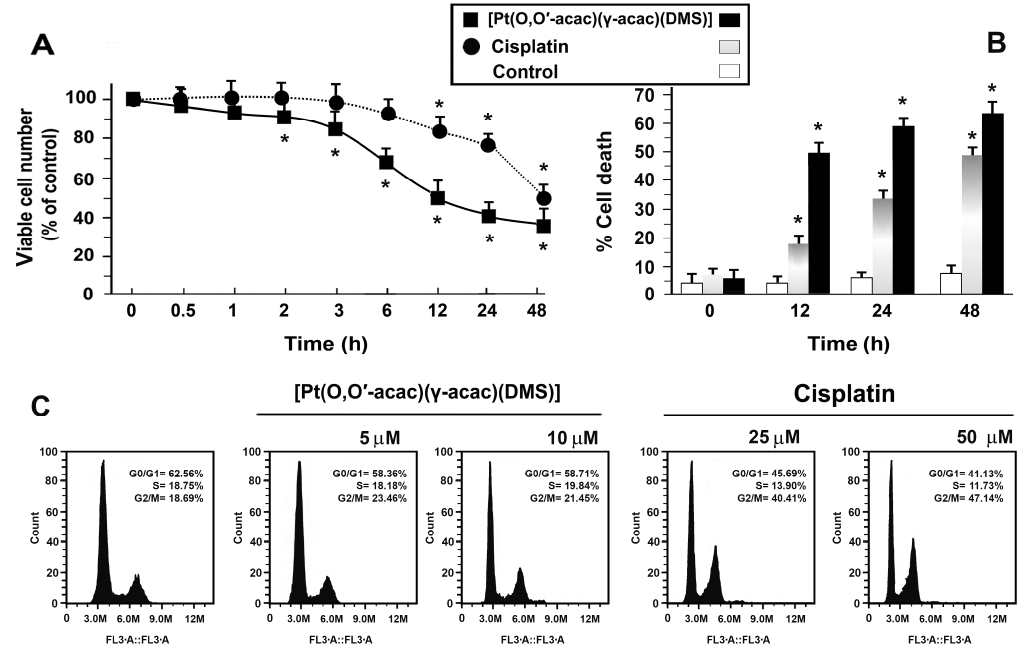
Figure 1. Cytotoxic effects of [Pt( O,O ’-acac)( γ -acac)(DMS) and cisplatin and effects on the cell cycle of Caki-1 cells. Caki-1 cells were treated with 10 µM [Pt( O,O’ -acac)( γ -acac)(dimethyl sulfide (DMS))] or with 50 µM cisplatin. Cell viability was monitored by 3-(4,5-dimethylthiazol-2-yl)-2,5-diphenol tetrazolium bromide (MTT) assay ( A ) and cell death was quantified by fluorescence-activated cell sorter (FACS) after propidium iodide (PI)/annexin V-fluorescein isothiocyanate (FITC) staining ( B ), over a period of 48 h. Data are means ± standard deviation (SD) of five independent experiments with eight replicates in each, and are presented as percent of control. * p < 0.01 between treated and untreated cells (white bar), by Student’s t -test. ( C ) Cells were treated with [Pt( O,O’ -acac)( γ -acac)(DMS)] or cisplatin for 24 h, and cell cycle distribution was analyzed by flow cytometry after staining the cells with PI. Representative FACS histogram from six separate experiments is shown.